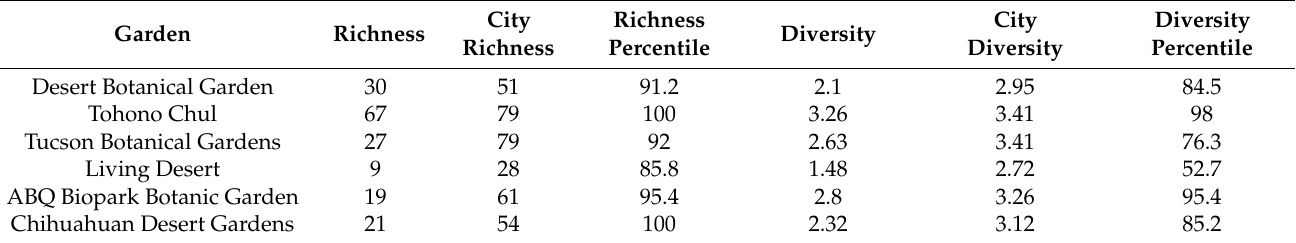
Figure 2. Comparison of species richness in botanical gardens to samples of identical geographic size within city boundaries. Violins show distribution of richness based on 1000 replicates and triangles show observed species richness for corresponding gardens. Table 3. Species richness and diversity (Shannon’s Index) for each botanical garden. Percentiles are observed richness and diversity values relative to 1000 permutation sampling replicates in the corresponding